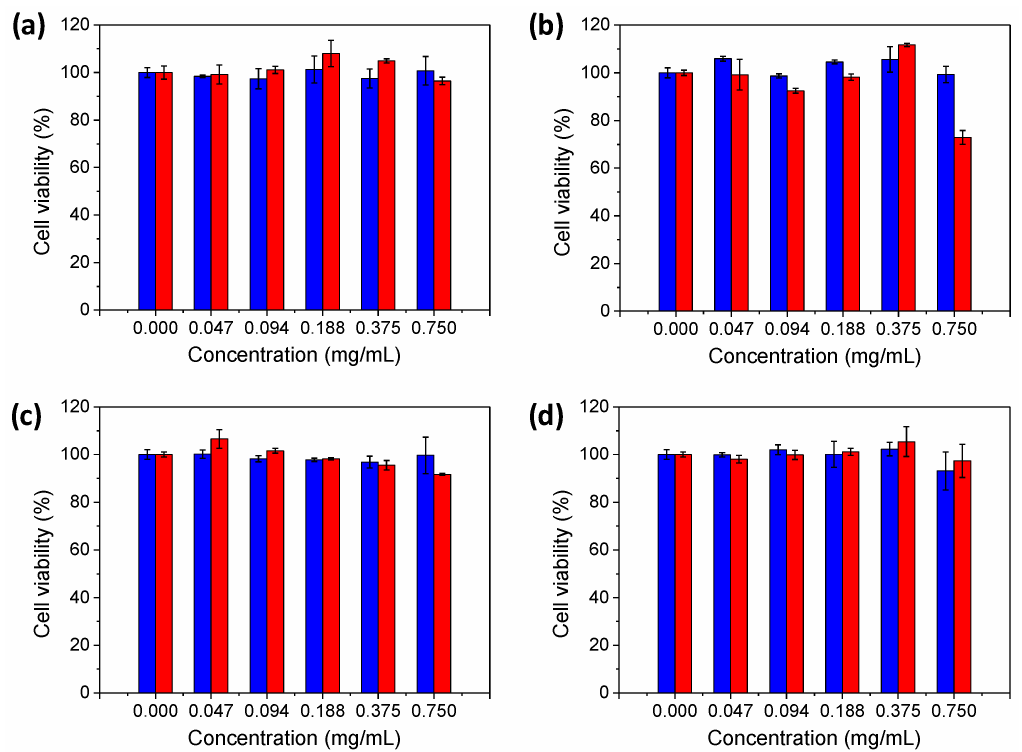
Figure 6. Cell viability in HeLa cell line of: ( a ) PAMAM32–ChCou , ( b ) PAMAM64–ChCou , ( c ) PAMAM16– cov –ChCou and( d ) PAMAM64– cov –ChCou self-assembliesatincreasingconcentrations after 24 h ( blue bars ) and 72 h ( red bars ) incubation